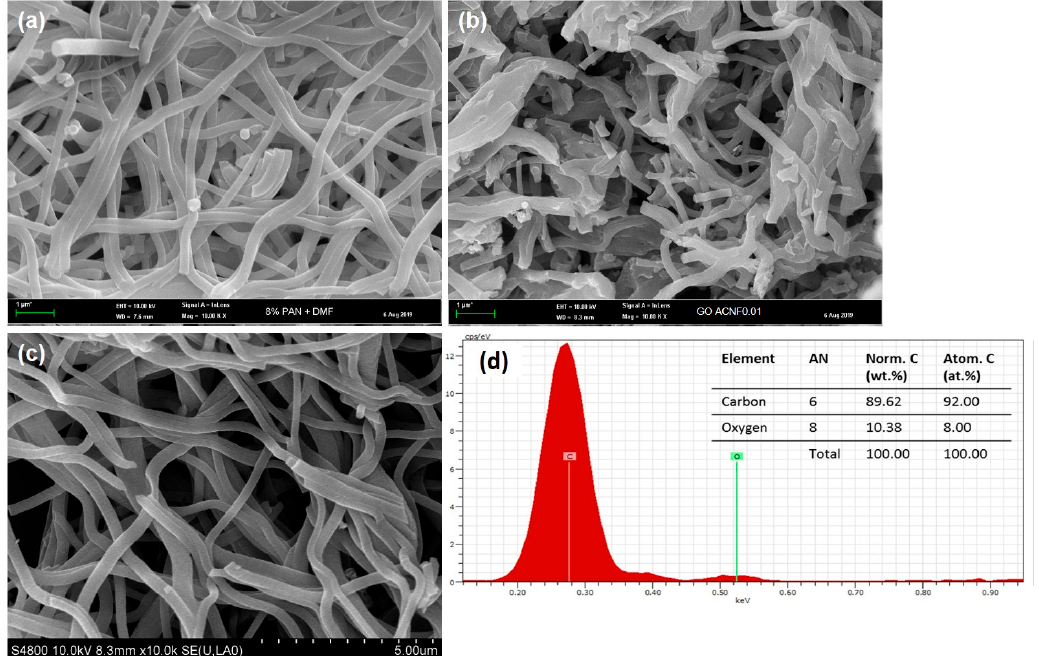
Figure 6. The morphology of ( a ) pristine activated carbon nanofibers (ACNFs) with different graphene-based additives, ( b ) with reduced graphene oxide (rGO), ( c ) with graphene-derived rice husk ashes (GRHA), and ( d ) EDX mapping of rGO/ACNF.